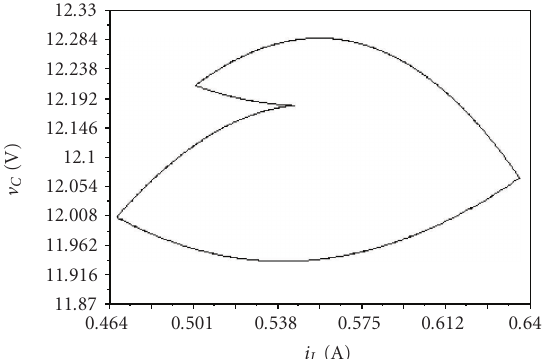
Figure 11: Chaotic regime. ( E = 46 . 5 V): time waveform of the capacitor voltage.